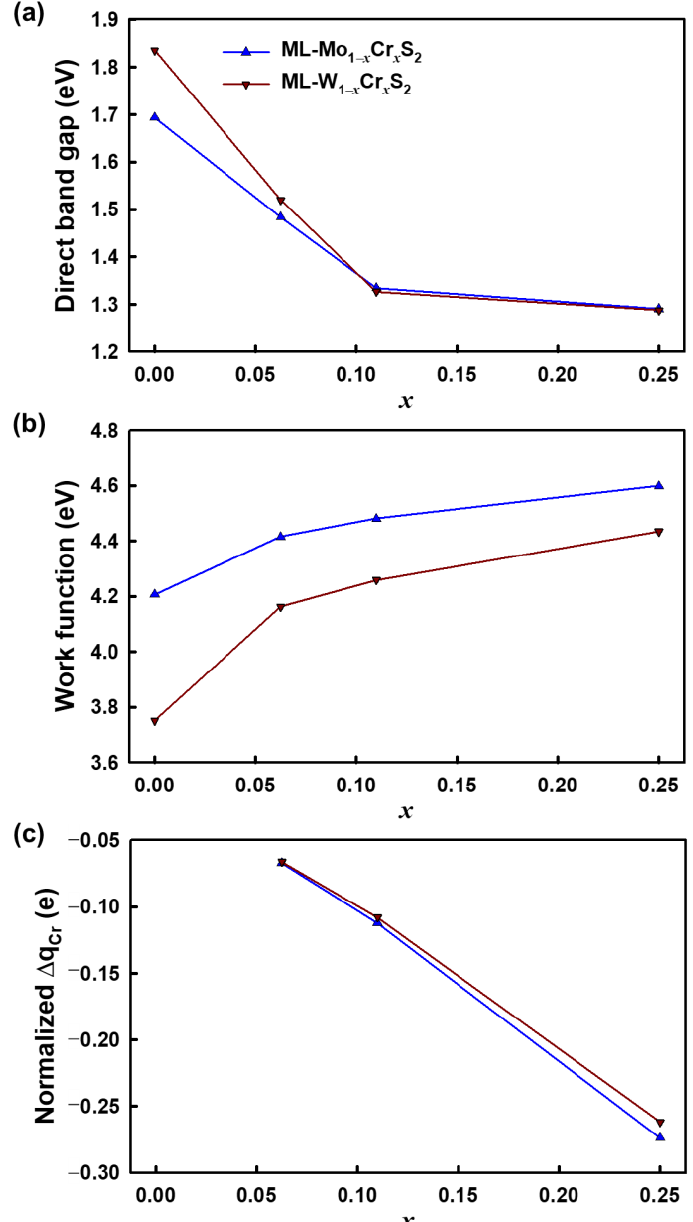
Figure 5. The values of ( a ) direct band gaps, ( b ) work functions, and ( c ) charge transfers of the Cr for the studied materials with respect to different mole fractions. ( a ) Additional simulations were considered for the mole fraction of 0.11 to provide the best estimation of the energy band gap. The results indicate that the variation with respect to the mole fraction of Cr was nonlinear, and the effect was marginal for a large mole fraction. ( b ) The work function increased when the composition of the Cr increased. ( c ) The electron-charge transfer of the Cr atom was analyzed via Bader charge analysis [30]; negative values indicate the loss of an electron charge. The unit e is the elementary charge of an electron. The variations in the charge transfer were negligible for different mole frac- tions.